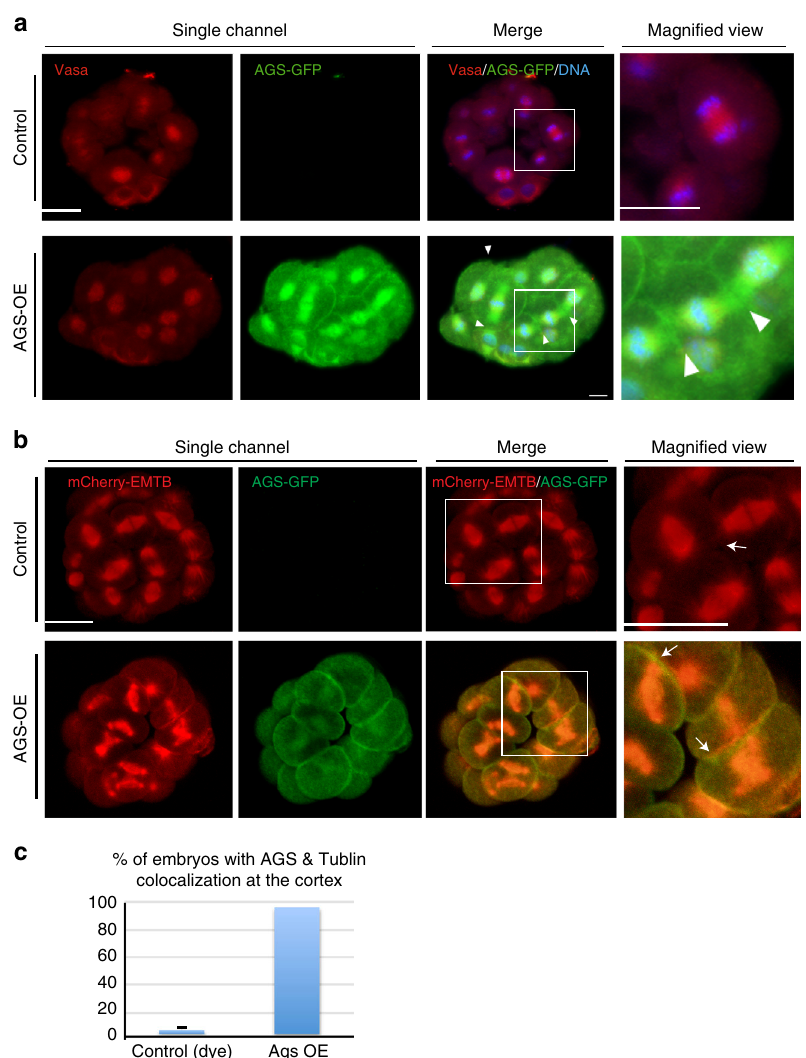
Fig. 5 Overexpression of AGS changes spindle orientation and anchoring. a AGS-GFP overexpression (AGS-OE; 1 μ g/ μ l) changed overall embryo morphology at the 16-cell stage. Images were obtained by immuno fl uorescence with methanol fi xation that diminishes the live GFP signal. The AGS-GFP signal was thus visualized by anti-GFP antibody. At M-phase, spindle orientation was randomized and many of the spindle poles were anchored to the nearby cortex (arrowheads in the magni fi ed view). ~50% of embryos showed phenotype, n = 14. b , c AGS-OE caused ectopic recruitment of microtubules labeled by mCherry-EMTB to the cortex (arrows) in over 80% of embryos, n = 25. Images taken are from live embryos. Each experiment was performed at least three independent times. Scale bars = 20 μ